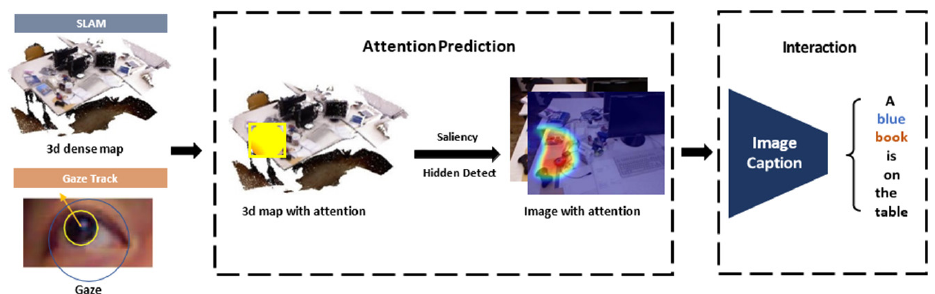
Figure 2. The system takes a video as input. It builds a map and estimates the gaze simultaneously. Then, an attention heat map is predicted. Finally, the system selects the attention region to generate a sentence from the image.